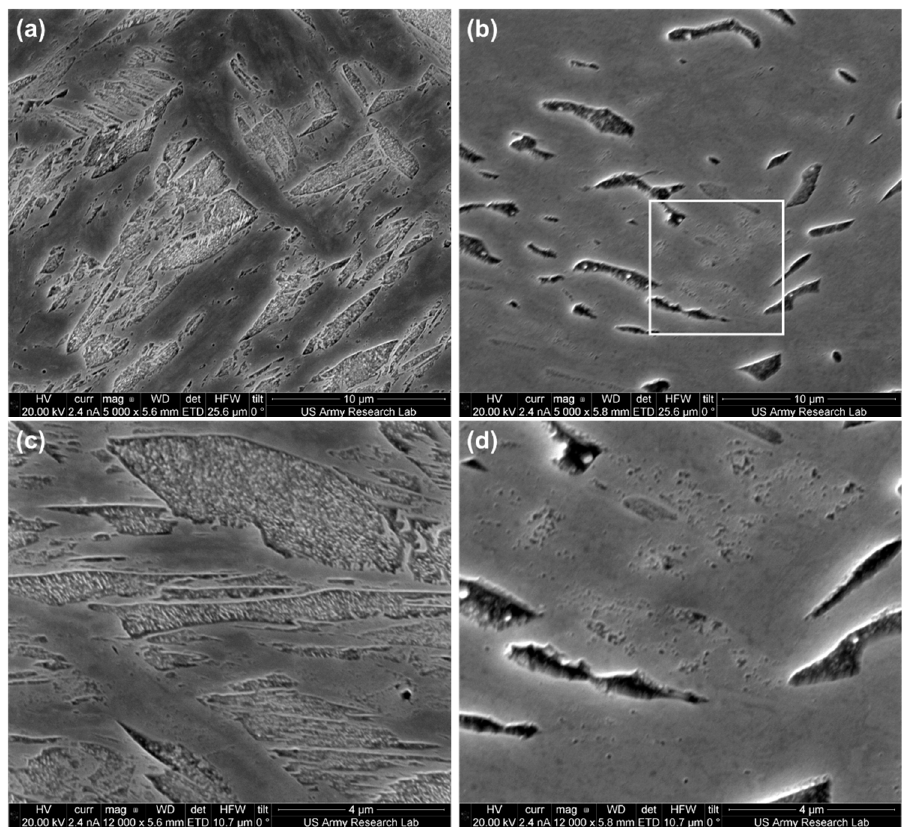
Figure 7. Secondary Electron images of the ( a , c ) N H Q H and ( b , d ) N H Q L at low and high magnification, respectively, carbides are highlighted with arrows.